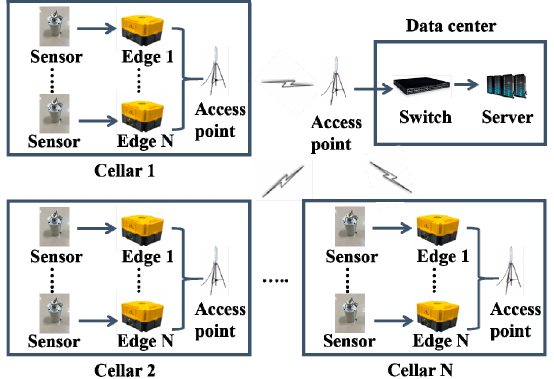
Figure 2. The structure of Edge-to-Center LearnReduce Microseismic Monitoring platform.